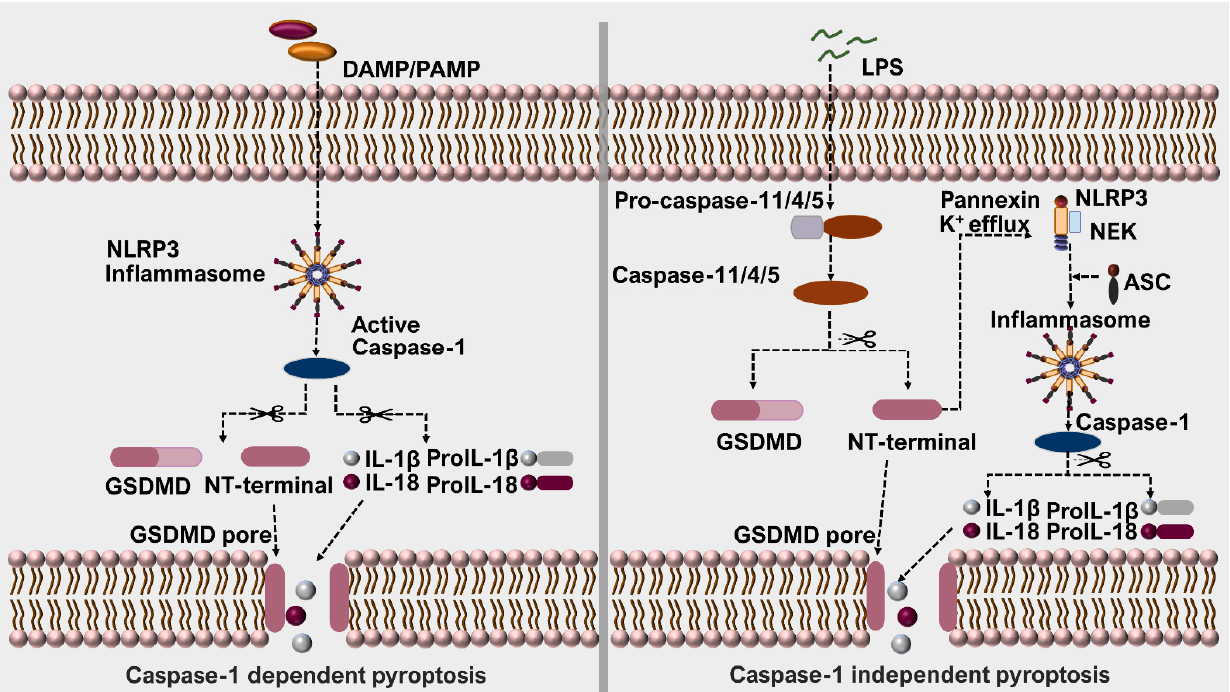
Figure 2. The mechanism of caspase ‐ 1 dependent and independent pathway. In the caspase ‐ 1 ‐ dependent pathway, DAMP and PAMP act by cleaving GSDMD, whilst GSDMD ‐ NT directly mediates the pore formation of cell membranes. In the caspase ‐ 1 ‐ independent pathway, caspase ‐ 11/4/5 are activated by LPS released from Grams ‐ negative bacteria to mediate pyroptosis. GSDMD ‐ NT generated from this process can also boost NLRP3 inflammasome activation and further induction of